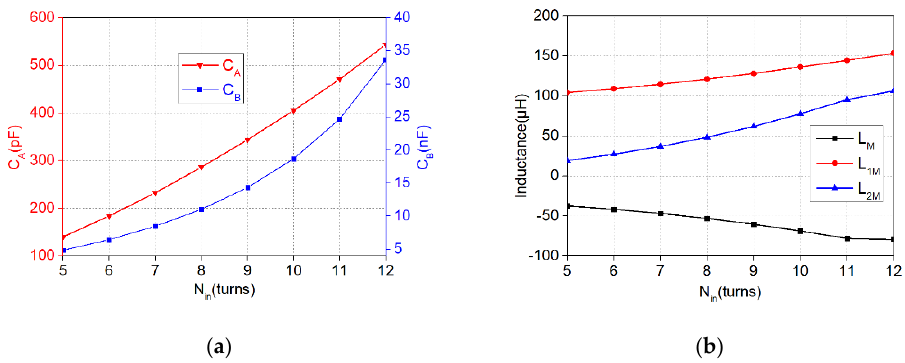
Table 1. Geometric parameters of electromagnetic coupler.